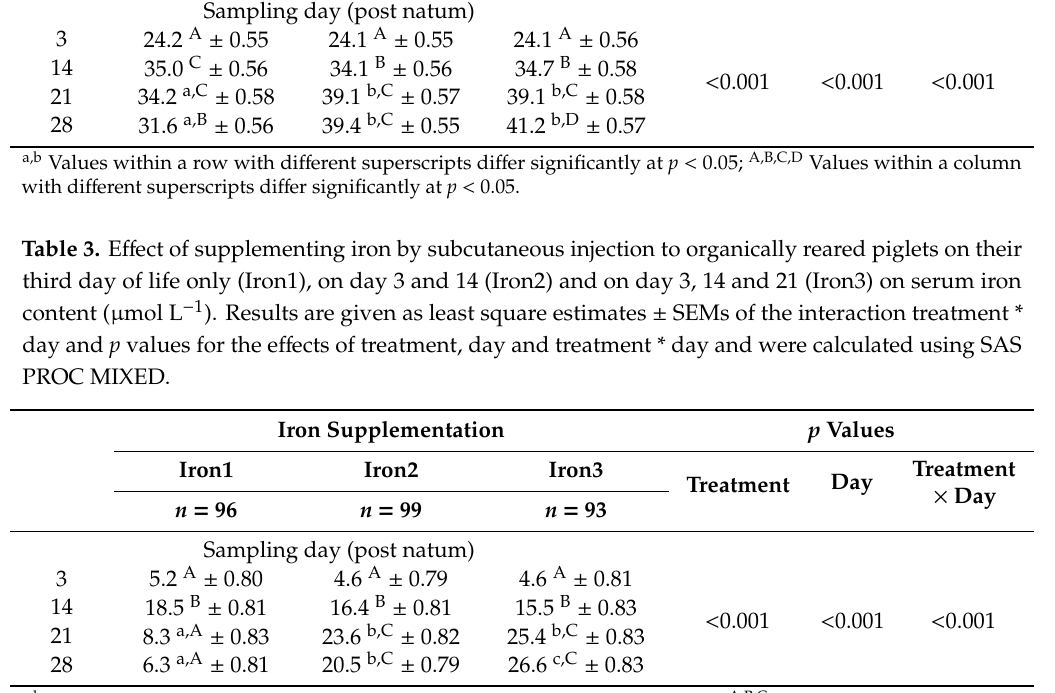
Table 2. E ff ect of supplementing iron by subcutaneous injection to organically reared piglets on their third day of life only (Iron1), on day 3 and 14 (Iron2) and on day 3, 14 and 21 (Iron3) on hematocrit content in blood (% by volume). Results are given as least square estimates ± standard errors of the means (SEMs) of the interaction treatment * day, and p values for the e ff ects of treatment, day and treatment × day, and were calculated using SAS PROC MIXED. Iron Supplementation p Values Iron1 Iron2 Iron3